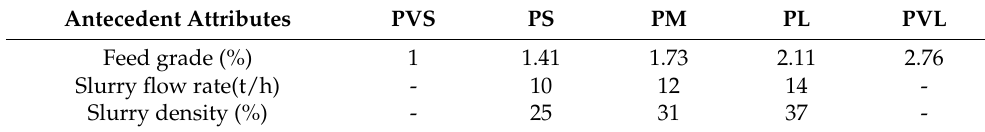
Table 3. Input referential values of antecedent attributes in antimony flotation. Antecedent Attributes